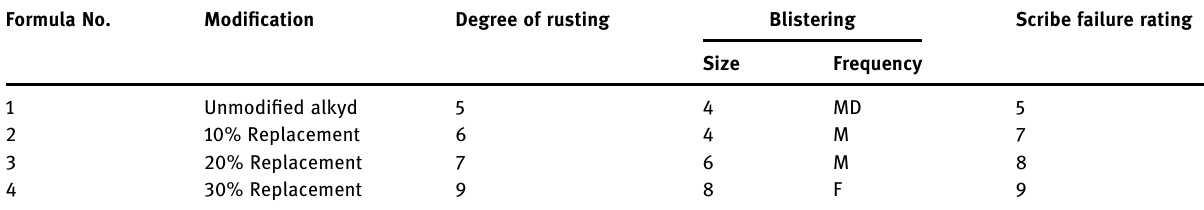
Table 7: Evaluation of corrosion resistance of the dry painted fi lms Formula No.